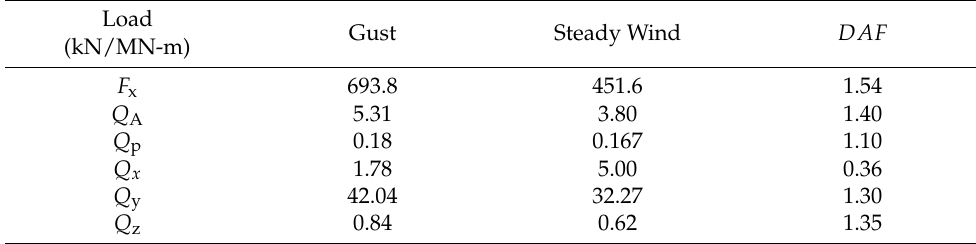
Figure 17. Time history of amplification factor for F x . Table 7. Dynamic amplification factor for the wind turbine with a blade configuration of 0°–120°– 240°.